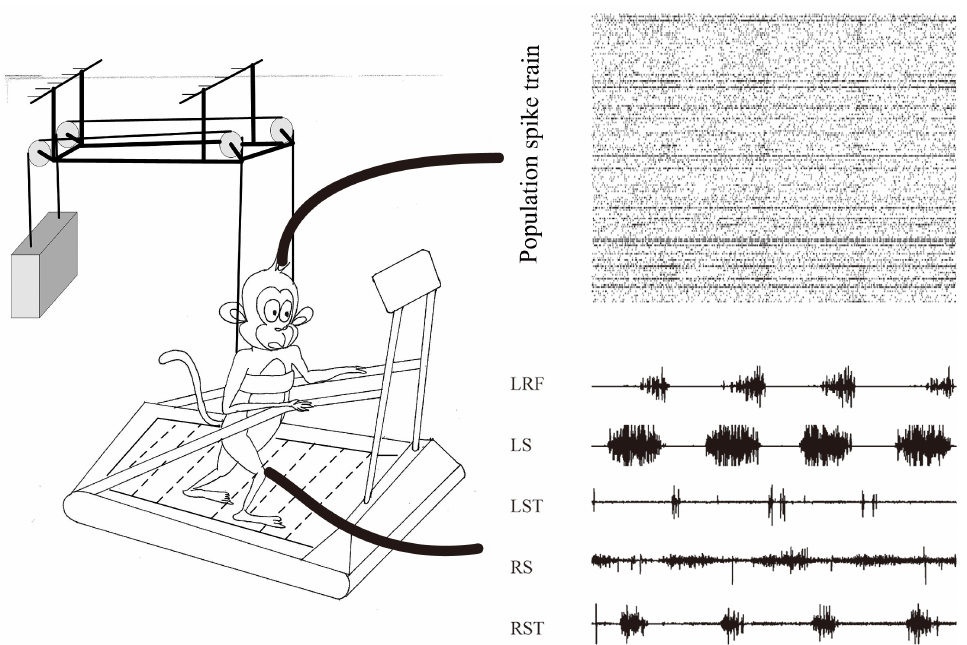
Figure 1. Schematic illustrating the behavioral task and data acquisition. The monkeys were restricted by a Derlin tube and a cloth sling on the handrails to walk bipedally on the treadmill. Spike trains from unilateral M1 area and various EMG activities from bilateral